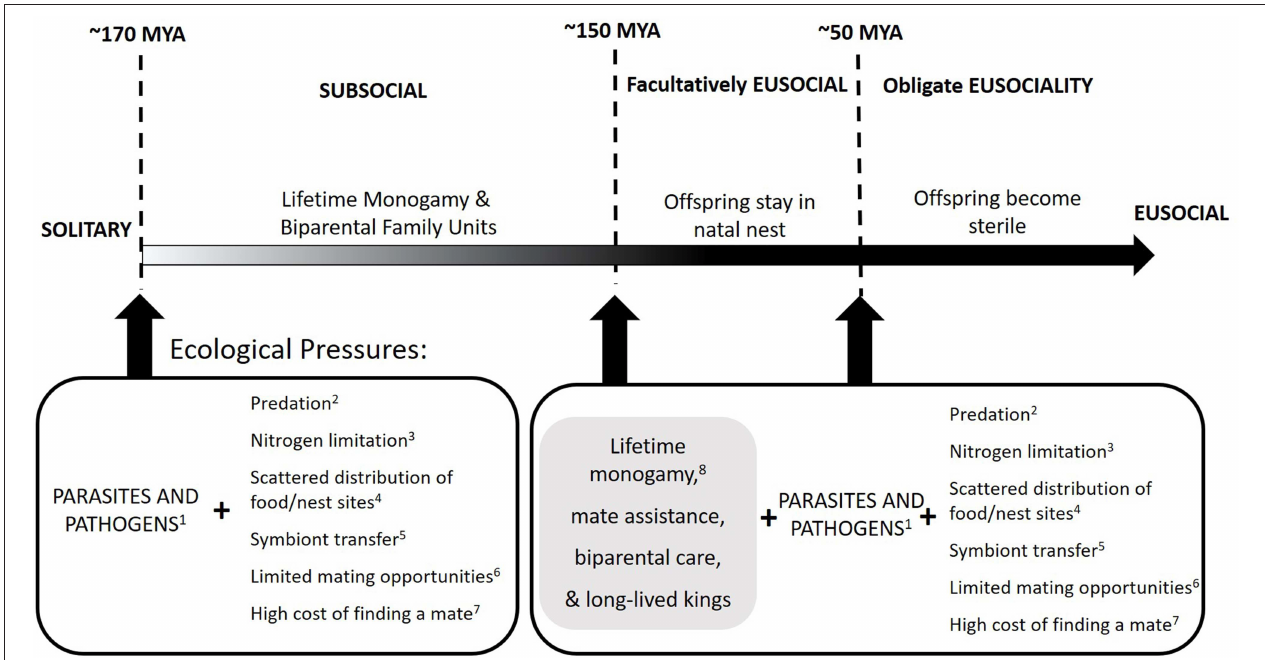
FIGURE 1 | Proposed scenario of the evolution of termite sociality. Based on basic termite biology, previous empirical studies and theoretical frameworks, we propose an evolutionary scenario in which the transitions between levels of social complexity occurred along a continuum, spanning ∼ 120 million years (MYA). Throughout this continuum, multiple, and sustained ecological pressures (including pathogenic stress) likely promoted the transition from a solitary to a subsocial lifestyle, which in the putative termite ancestor, likely consisted of monogamy, longer life expectancies of parents, mate assistance, and biparental care. These subsocial traits served as preadaptations (in gray box) which, together with continued strong ecological pressures, might have selected for non-dispersing progeny who retained reproductive potential (facultative eusociality; Boomsma, 2009, 2013; Boomsma and Gawne, 2018) by around ∼ 150 MYA (Bourguignon et al., 2014). By ∼ 50 MYA (Bourguignon et al., 2014, 2017 ), the evolution of sterility in the offspring took place (obligatory eusociality; Boomsma, 2009, 2013; Boomsma and Gawne, 2018). Given the risks posed by multiple environmental stressors, the fitness benefits accrued by progeny while rearing siblings likely outweighed any benefits from nest dispersal and personal reproduction. The dashed lines represent the timing of these major transitions in social complexity ( Bourguignon et al., 2014, 2017; Harrison et al., 2018). Possible environmental factors influencing sociality throughout this continuum: 1 Cruse (1998), Schmid-Hempel (1998), Rosengaus et al. (2000, 2003, 2011), Tunaz and Stanley (2009), Chouvenc et al. (2011) and Wilson-Rich et al. (2007). 2 Delighne et al. (1981), Dial and Vaughan (1987), Lepage (1991), Matsuura and Nishida (2002) and Sheppe (1970). 3 Nalepa (1991, 2010, 2015), Hunt and Nalepa (1994), Higashi et al. (2000) and Shellman-Reeve (2013). 4 Hamilton (1978), Korb and Heinze (2008) and Nutting (1969). 5 Nalepa (1991, 2015). 6 Hamilton (1978) and Nutting (1969). 7 Hamilton (1978) and Nutting (1969). 8 Boomsma (2009,